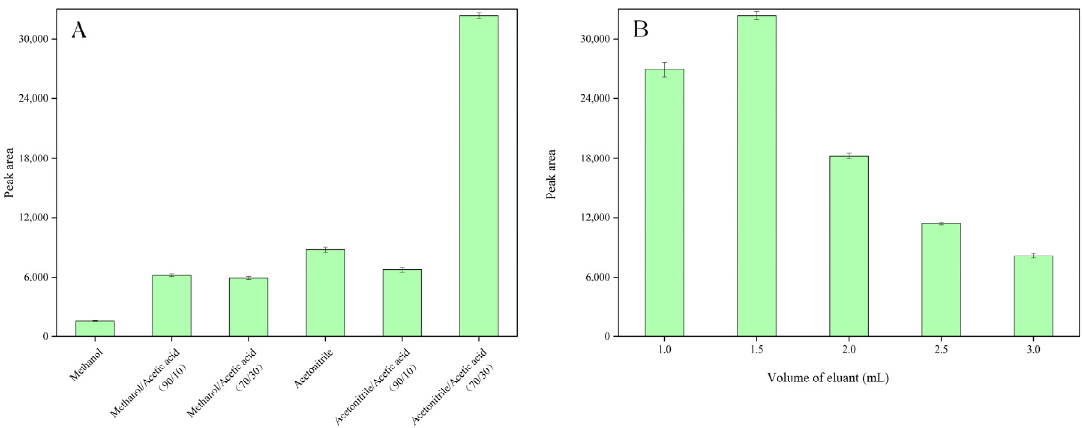
Figure 4. Effects of different types ( A ) and volumes ( B ) of eluents on elution efficiency.